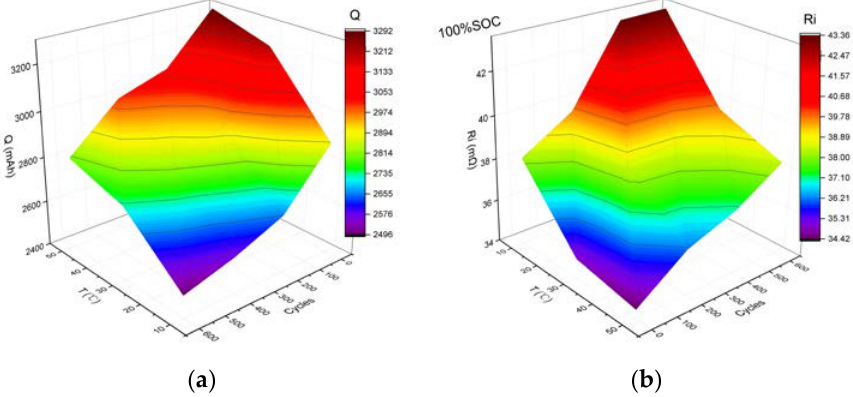
Figure 4. ( a ) Capacity changes for batteries; ( b ) internal resistance changes for batteries.